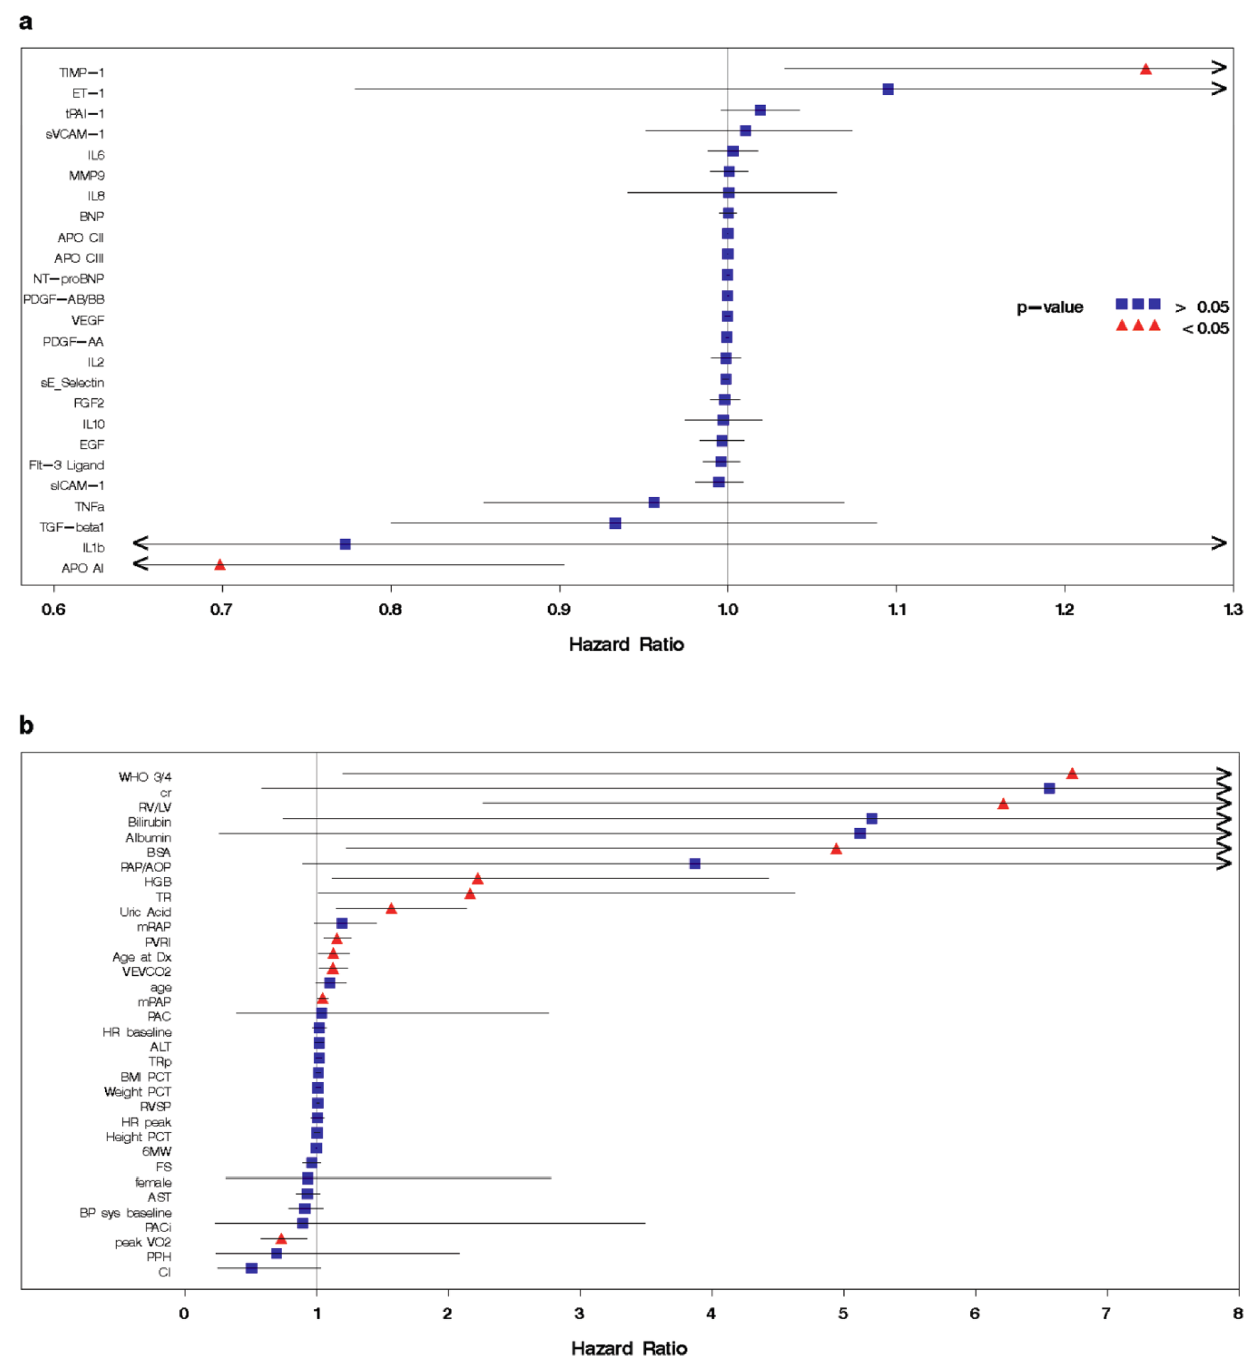
Figure 2. Univariate Cox regression results. Hazard ratios (points) and corresponding 95% confidence intervals (bars) for circulating proteins (a) and clinical variables (b). Variables with confidence intervals not including 1.0 are indicated with a red